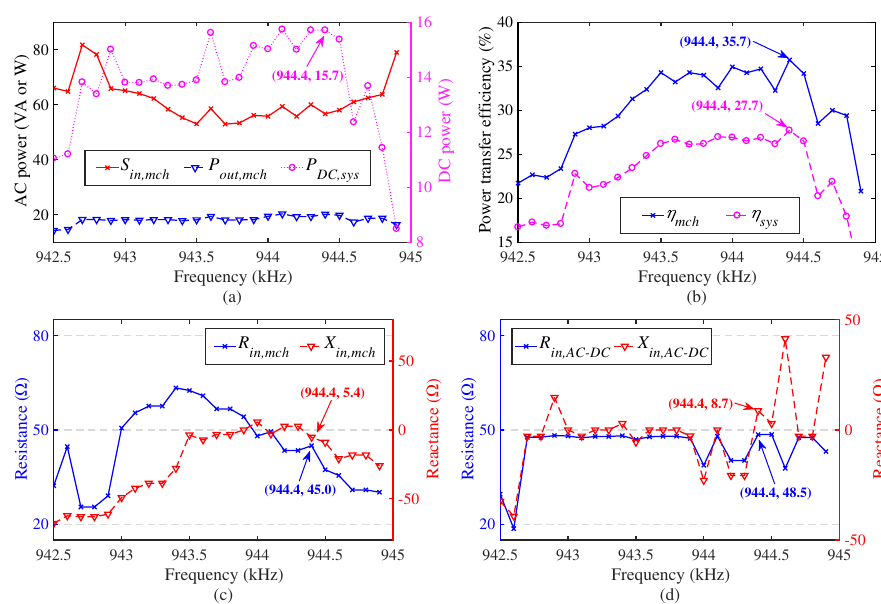
Figure 14. Measurement results of the system: ( a ) Input apparent power and output active power of the matched channel and DC output power of the system; ( b ) Power transfer efficiency of the matched channel and system; ( c ) Input resistance and reactance of the matched channel; ( d ) Input resistance and reactance of the AC-DC